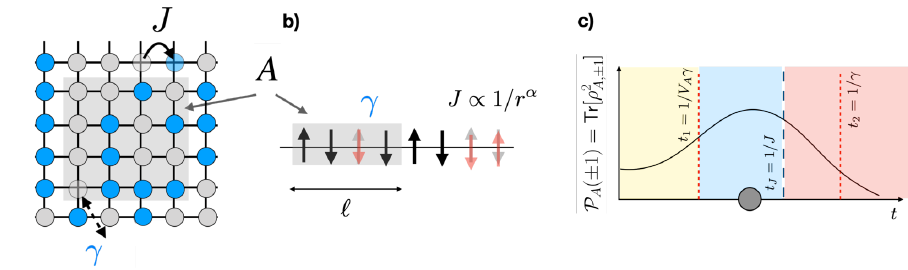
Figure 1: Evolution of symmetry-resolved entropies in NISQ devices. Panel a,b) : sketch of the models discussed in the main text. a) : free fermions on a square lat- tice, with tunneling matrix element J and one-body loss rate γ . b) : spin-1 / 2 chains with long-range XY exchange interactions, and single site spin relaxation rate γ . The grey areas represent the geometries of the A bipartition of linear length (cid:96) considered below. Panel c) : time evolution of the symmetry-resolved purity in the sector q = ± 1, ( ± 1 ) = Tr [ ρ 2 ] , in NISQ devices undergoing three distinct regimes (indicated by A , ± 1 P A different colors, see text for their relations to microscopic timescales). The purity ini- tially increases as a function of time, signalling dynamical purification (gray